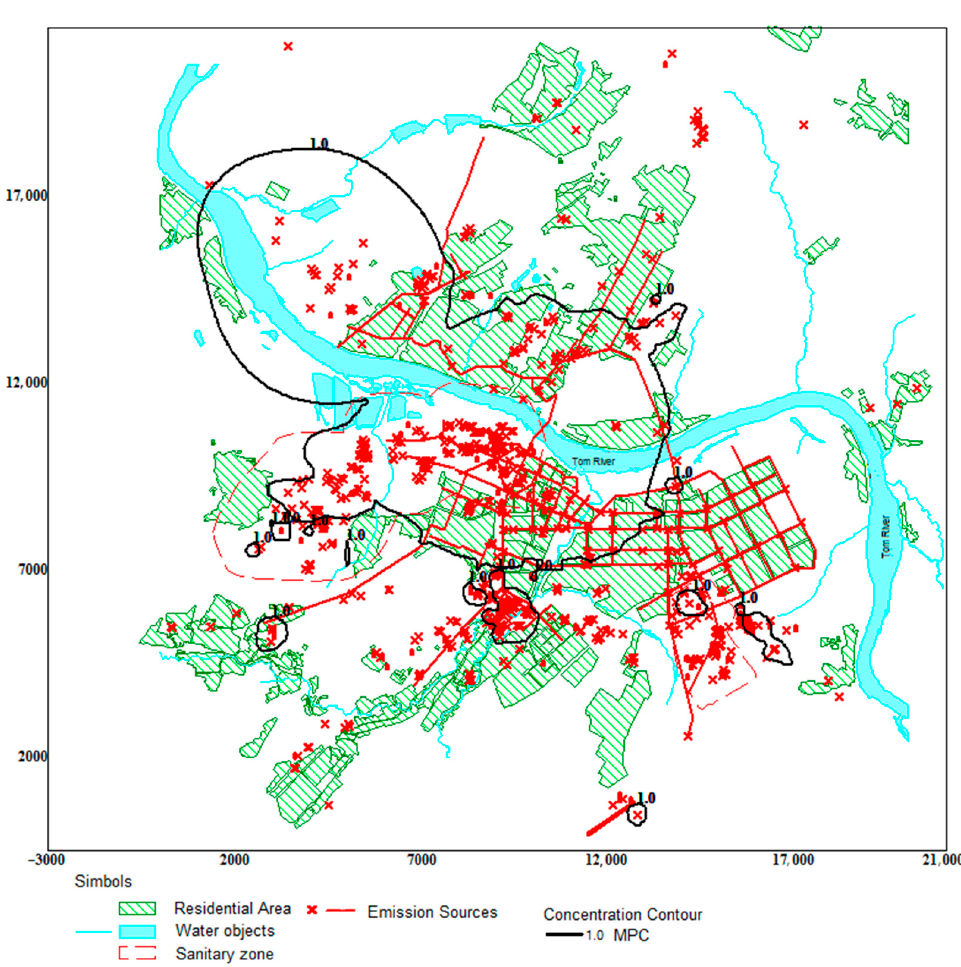
Figure 2. The area of excess (inside the black contours) of the calculated maximum one-time concentrations of nitrogen dioxide from the set of emission sources of Kemerovo city.